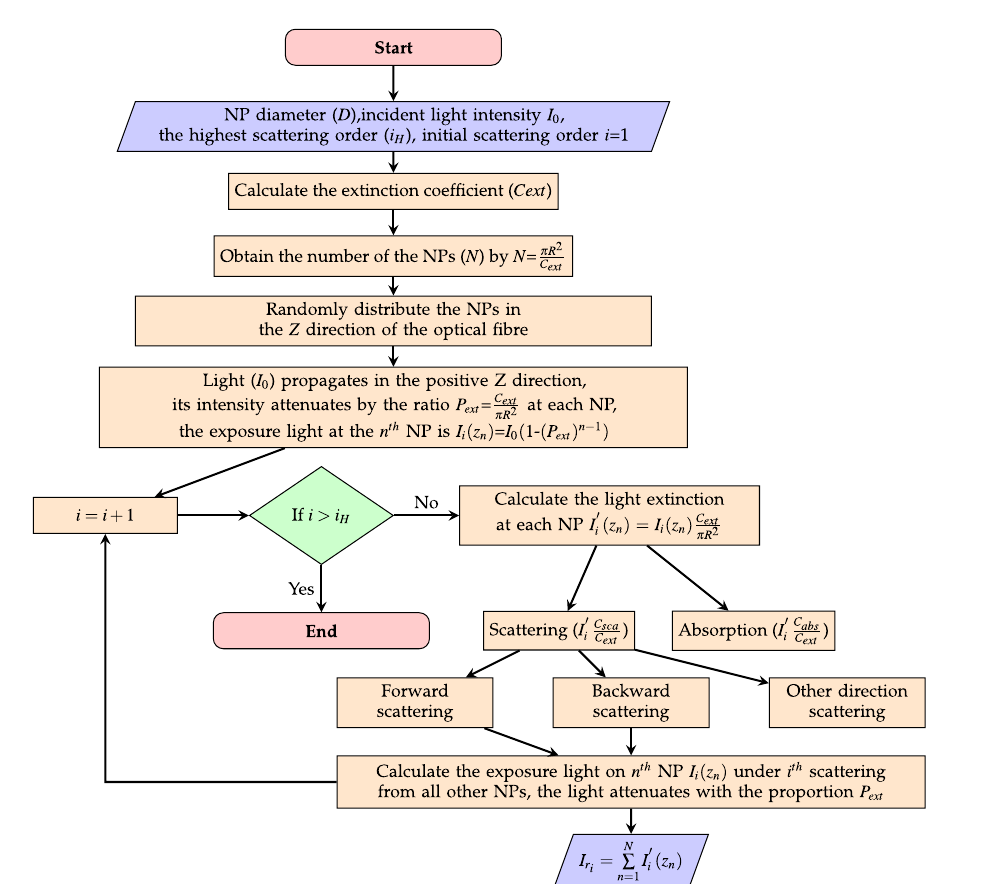
Figure 2. Flowchart of up to N th order scattering received from an optical fibre input